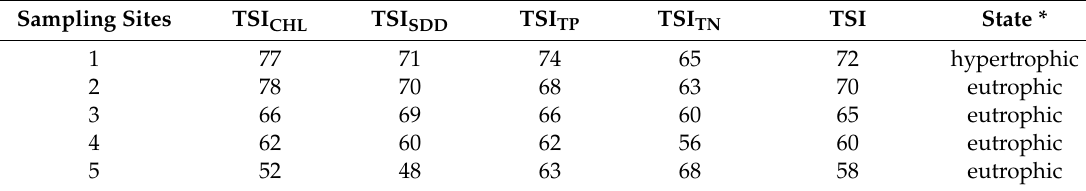
Table 1. Trophic state index (TSI) and its partial indices based on summer data on chlorophyll a Lake